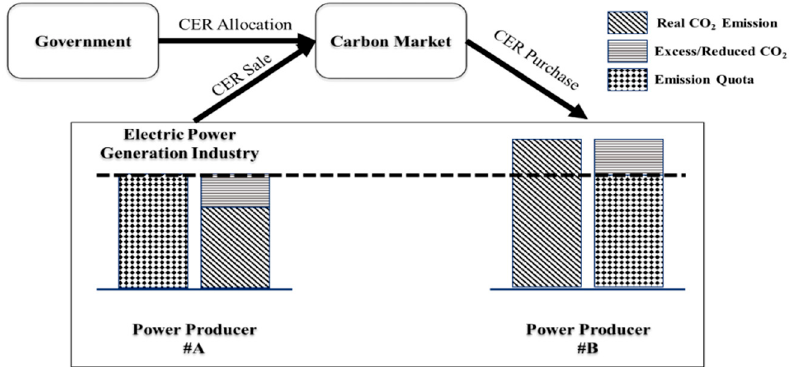
Figure 2. Diagram of the ETS mechanism. (ETS: Emissions Trading Scheme)